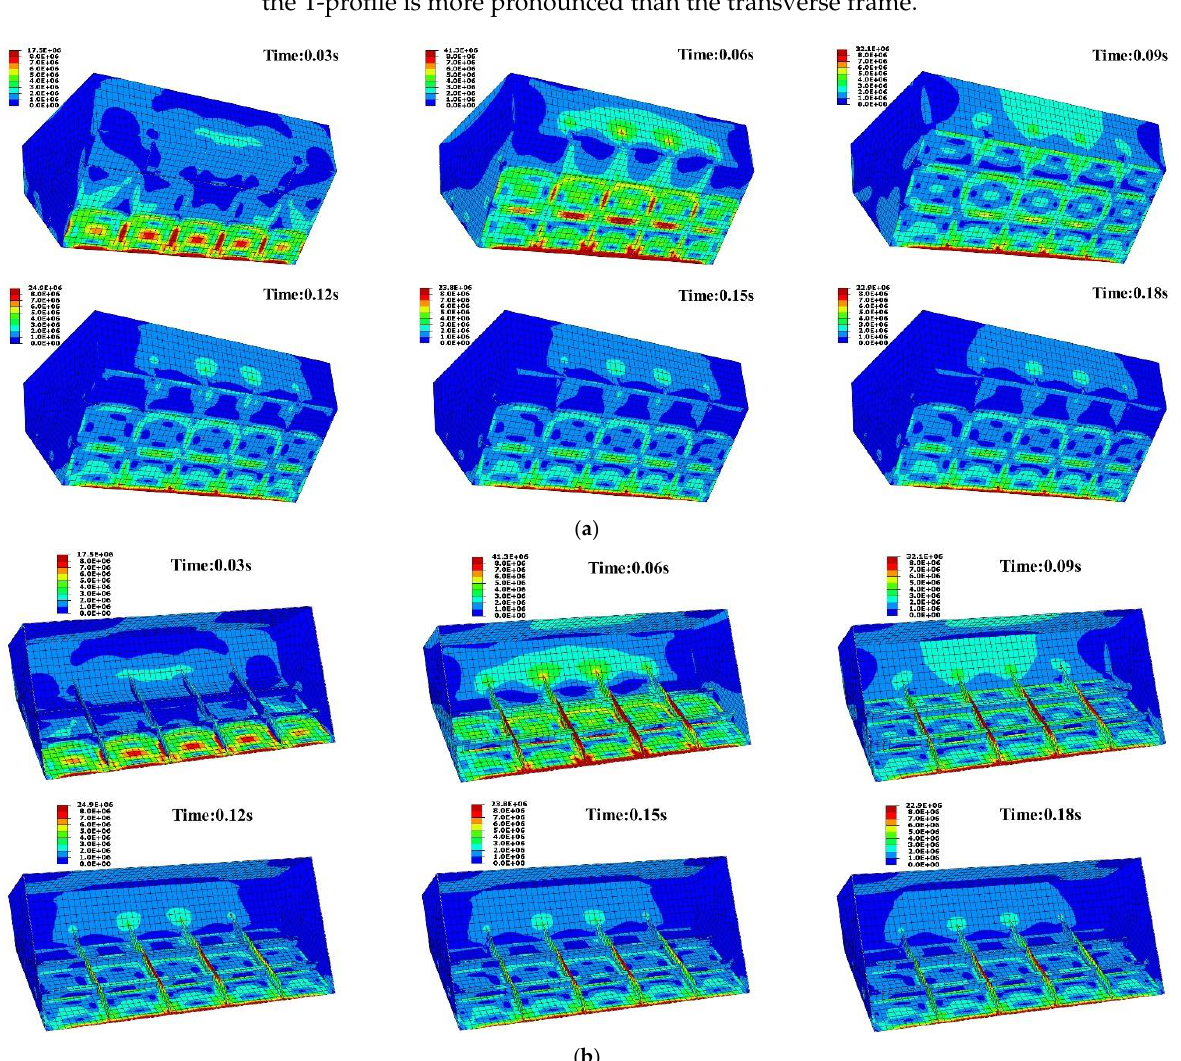
Figure 23. Structural stress distribution on the wedge structure (in MPa): ( a ) overview of the external surface; ( b ) overview of the internal grillage structure.